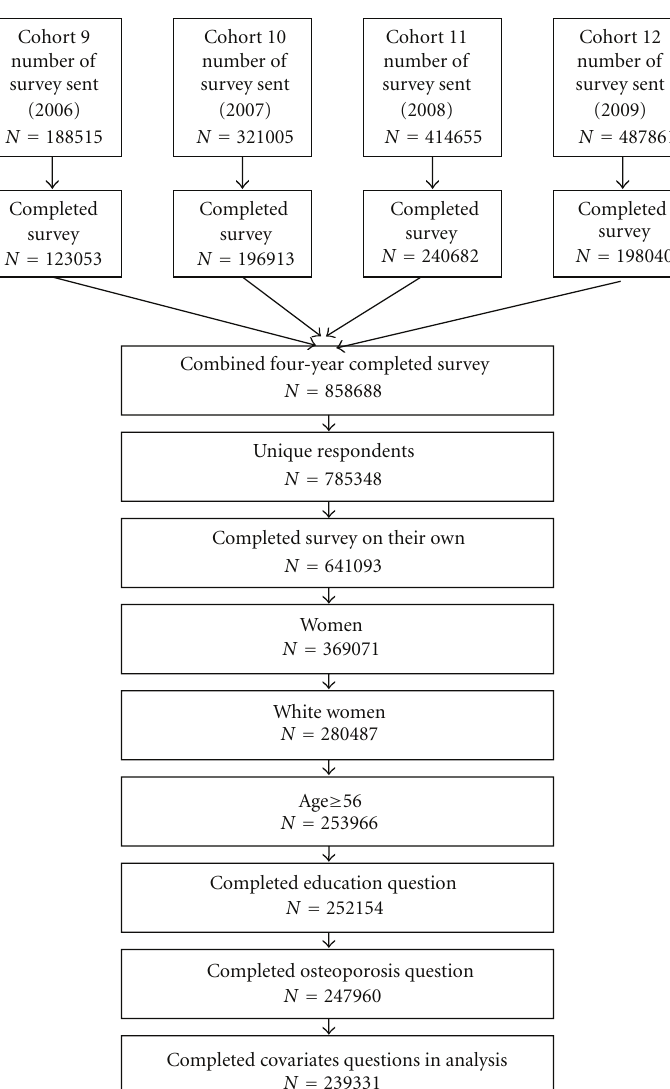
Figure 1: Data pool selection process (flow